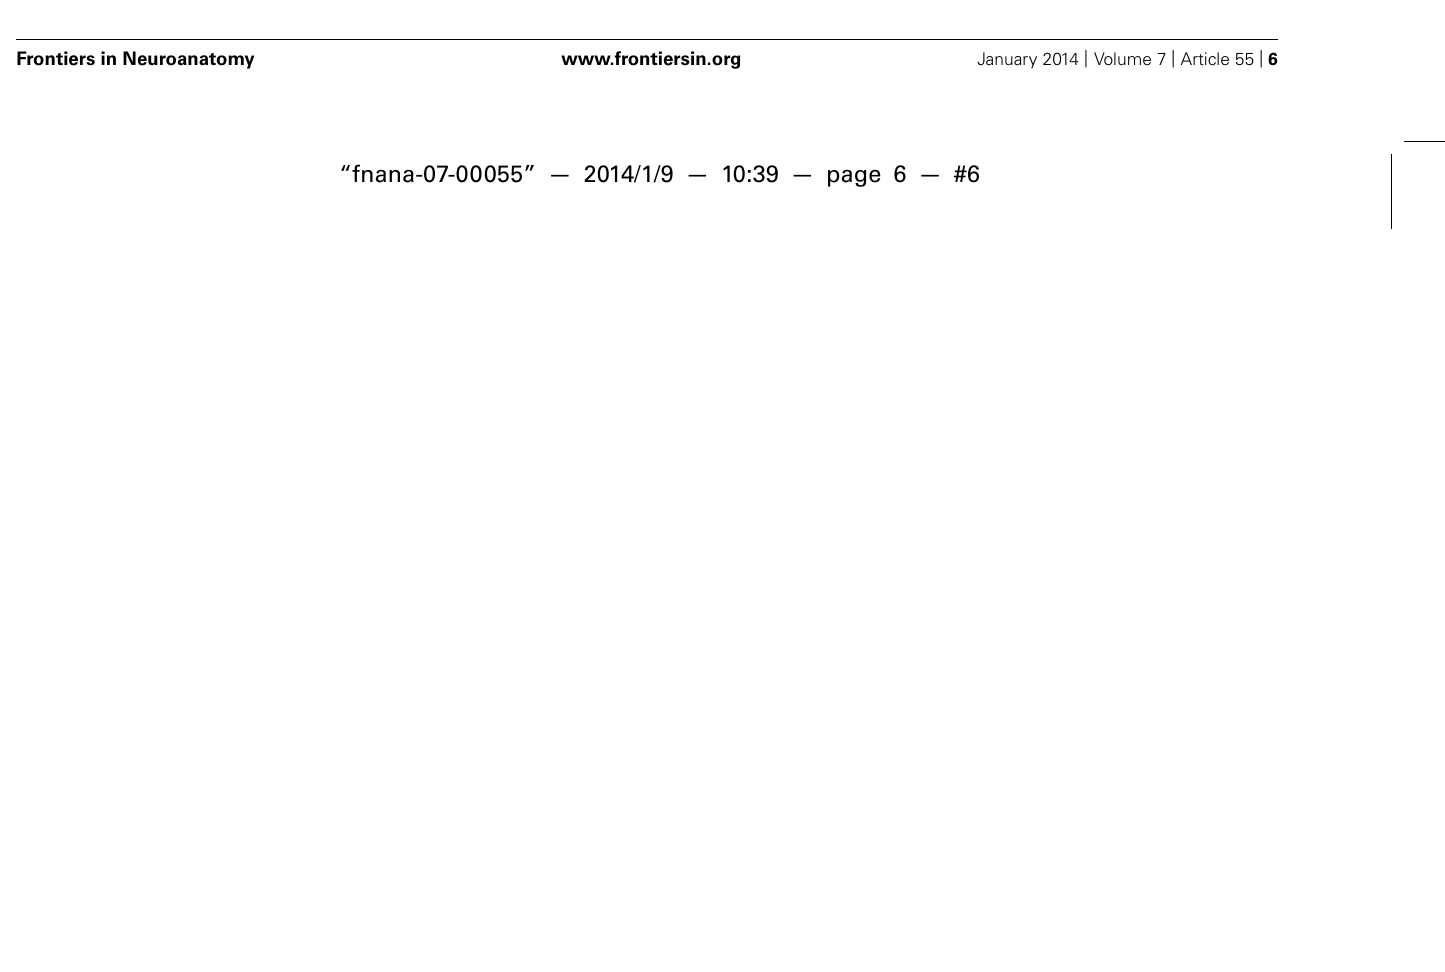
neurons.The pale fluorescent bodies (white arrows) appear to be glial nuclei. Lipofuscin (arrowheads) is present in the cytoplasm of a DY labeled cell (C) . Both (A,C) show faint membrane